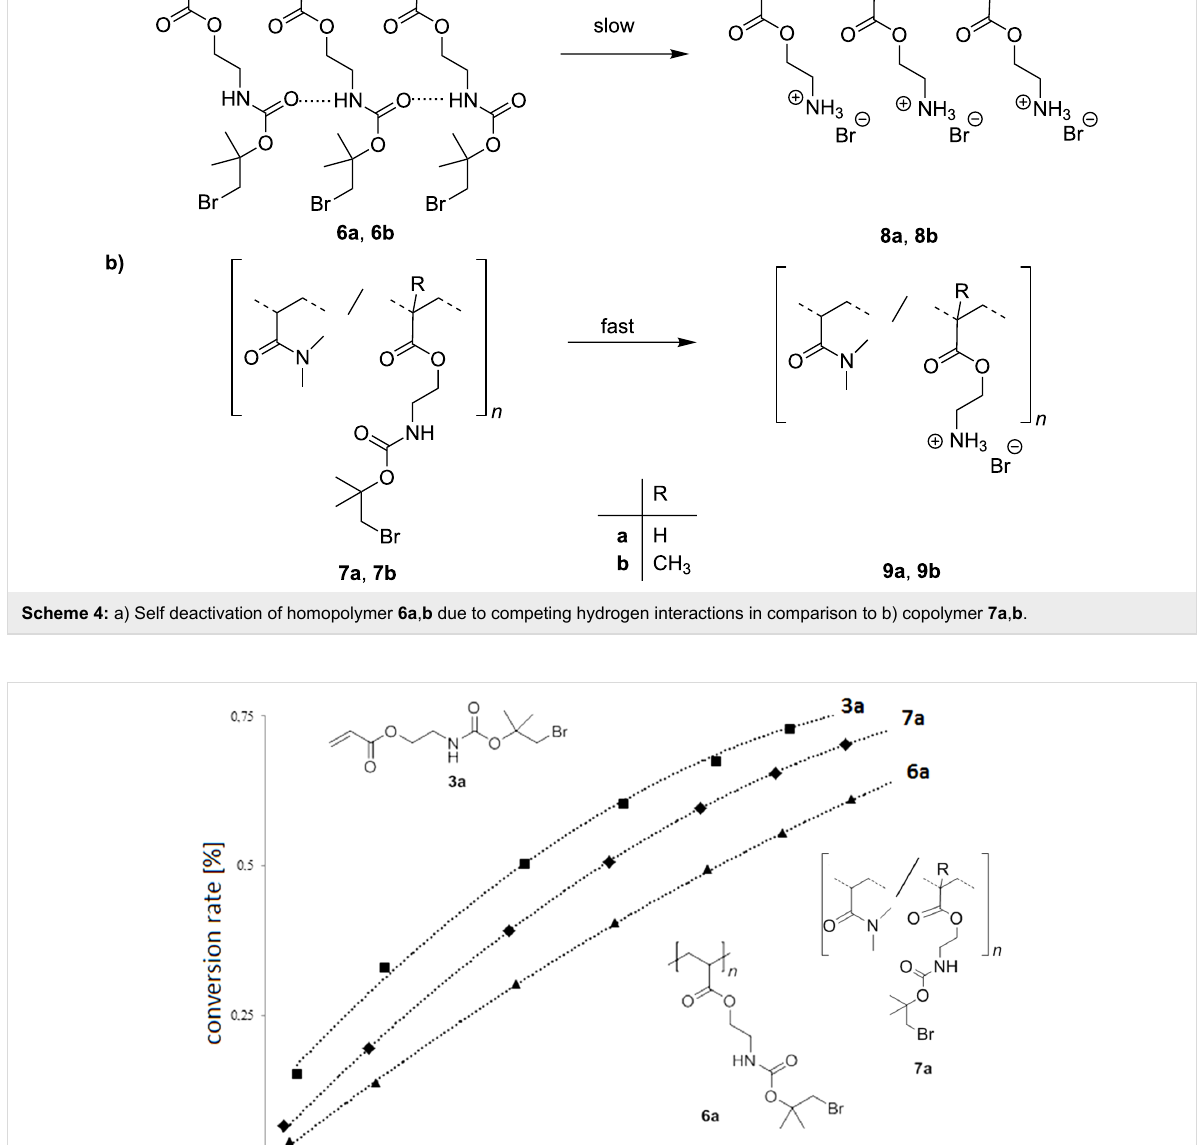
because of neighboring group formed retarding hydrogen bonds (Scheme